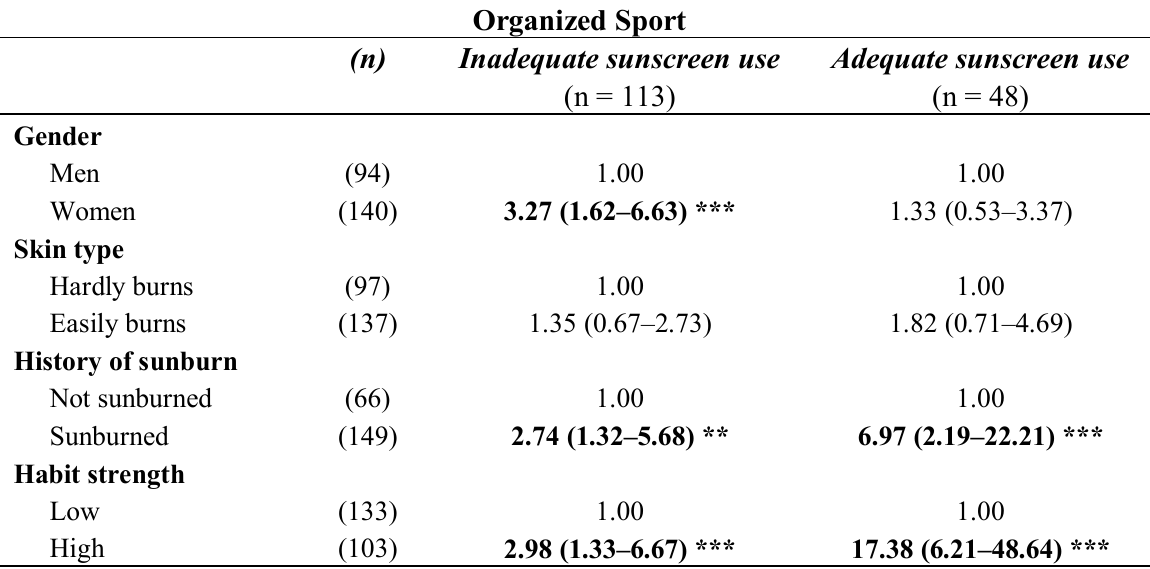
Table 1. Odds ratio (95% CI) of inadequate and adequate sunscreen use compared to no sunscreen use during organized sport.